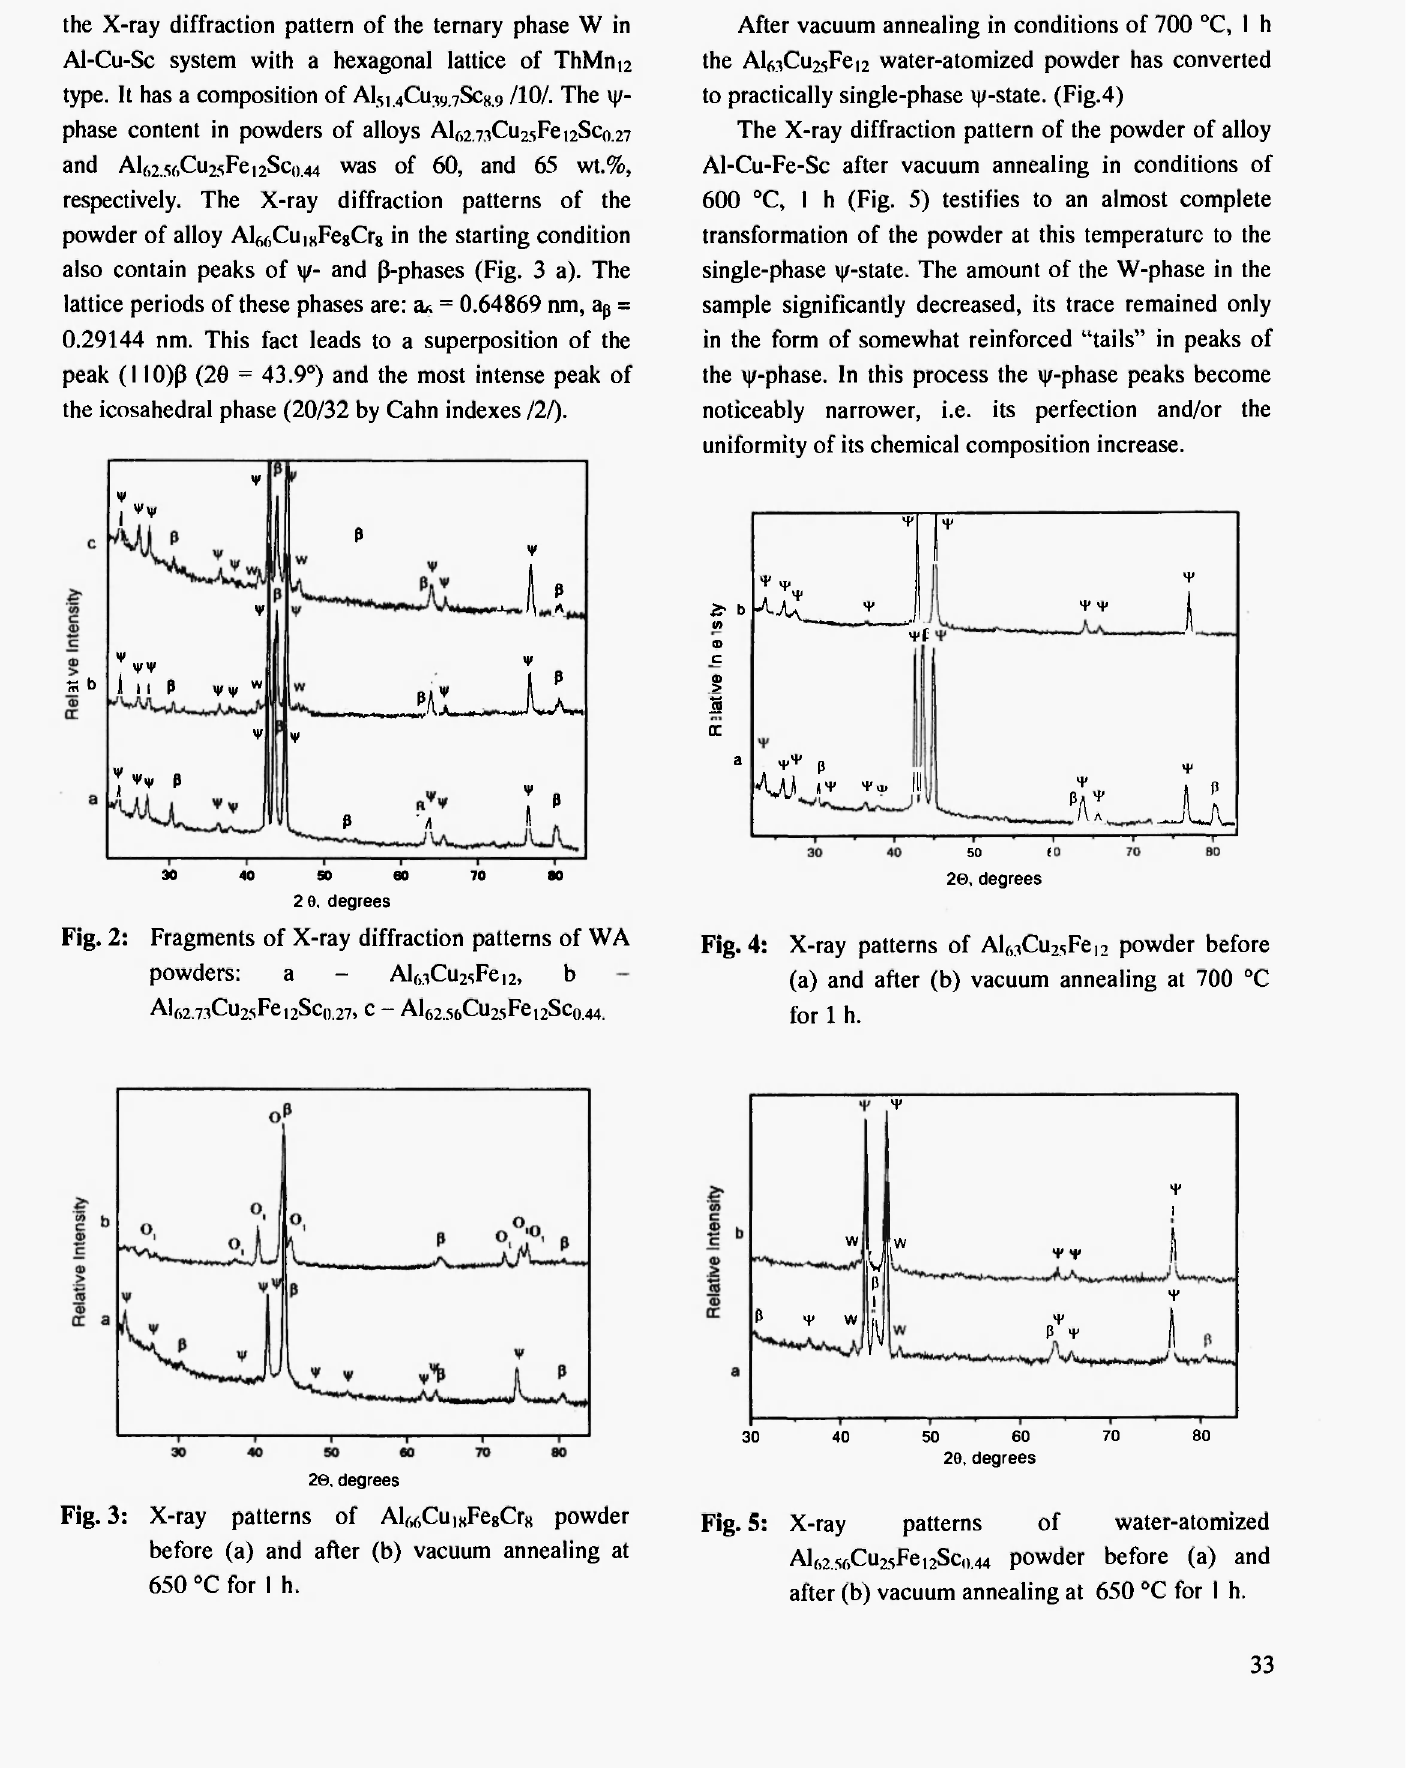
2Θ, degrees Fig. 3: X-ray patterns of Al f>6 Cu| X Fe s Cr K powder Fig. 5: X-ray patterns of water-atomized before (a) and after (b) vacuum annealing at Alft2.5ftCu25Fe12Scn.44 powder before (a) and 650 °C for 1 h. after (b) vacuum annealing at 650 °C for 1 h.